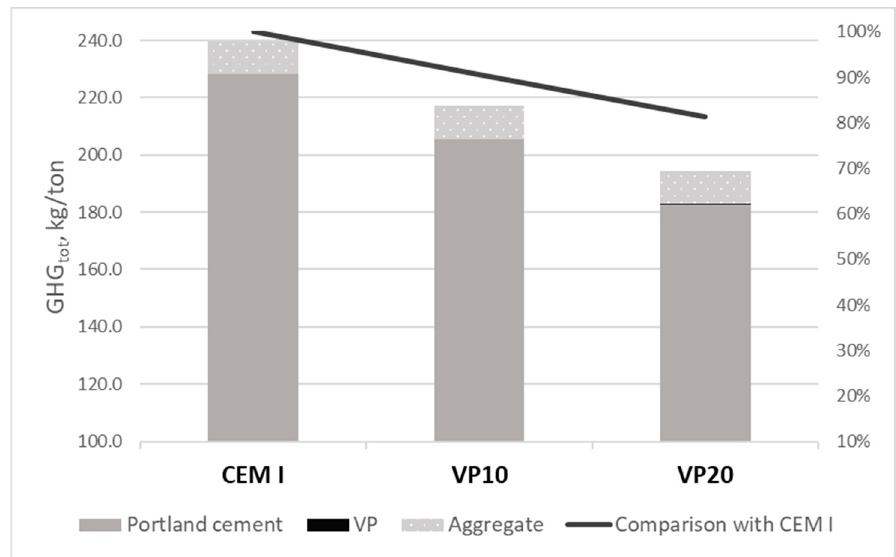
Figure 18. Results of total greenhouse gas emissions (GHG tot ) associated with the mortars studied.